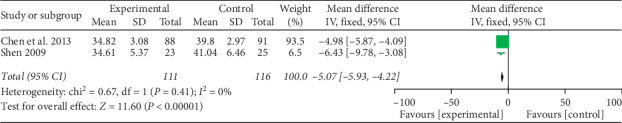
Quality of life: experimental groups compared with control groups.